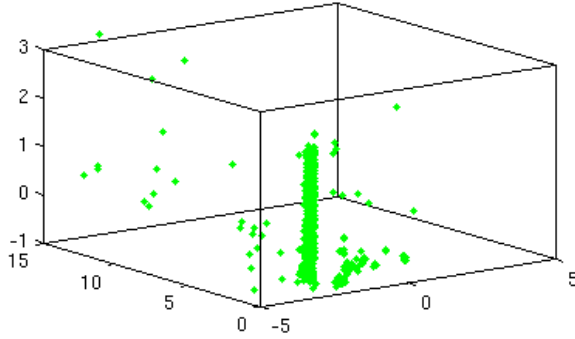
Figure 5: Part of a 3D point cloud. The trunk of a tree is clearly seen. The axis unit is